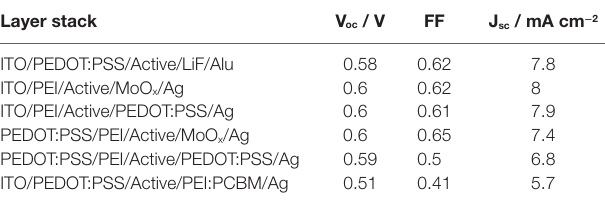
TaBle 1 | Device parameter obtained for the indicated layer